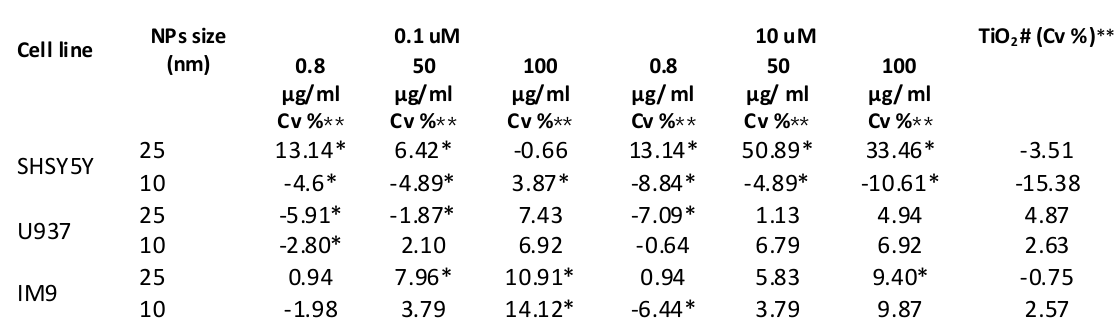
Table 4.: The effect of two different sizes of TiO treated only.Re ** Increase in cell viability (per cent) at the end of the 24-hour incubation period. # The mean value of cell viabilities (per cent) for ten different concentrations (from 0.2 m g/ml to 100 m g/ml) of TiO2 NPs at the end of the 24-hour incubation period.